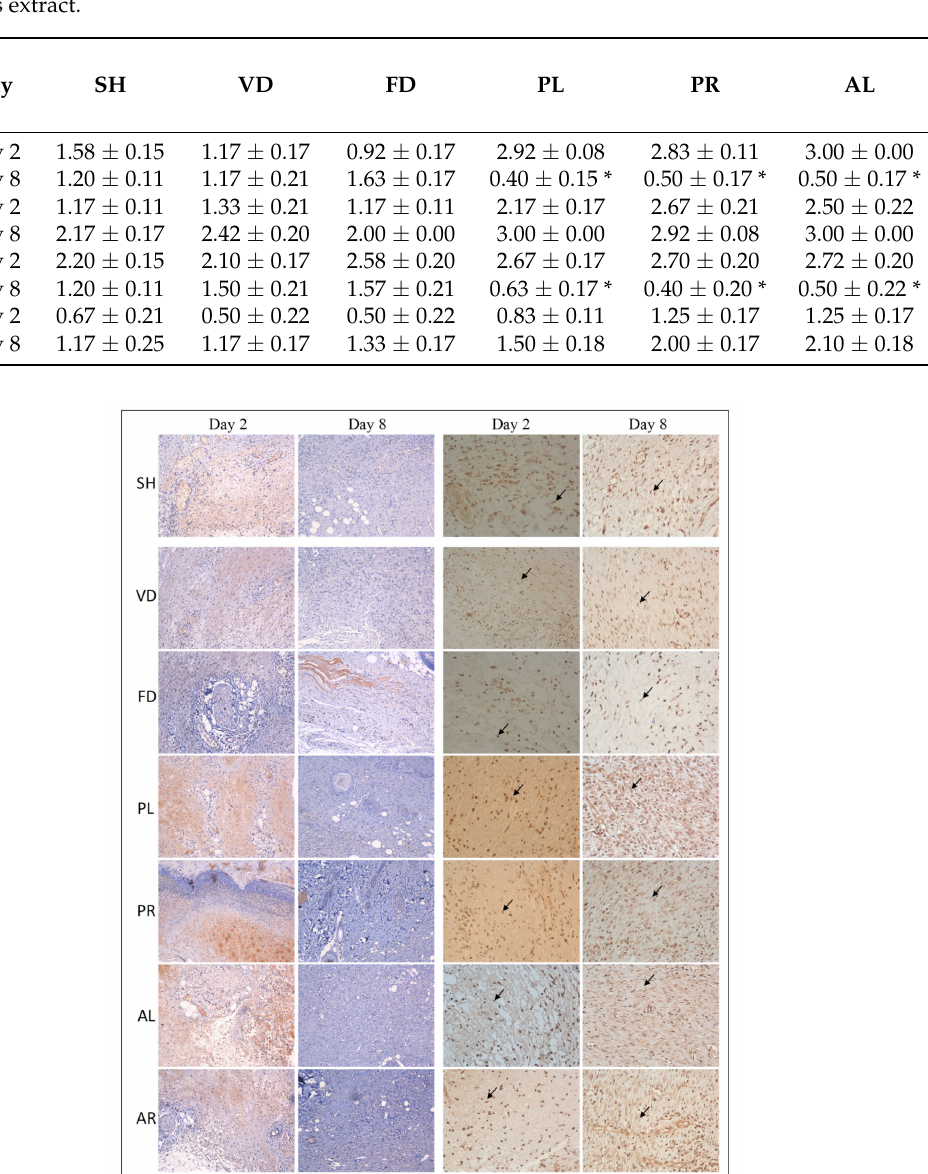
Table 5. Mean score of proteins expression obtained by immunohistochemistry (IHC) staining of seven male rat experimental groups: SH, VD, FD, PL, PR, AL, and AR. All data are given as mean ± S.E. for six animals in each group. Statistically significant results are indicated as (*) p < 0.05 versus untreated and control groups (SH, VD, and FD) on the same day. SH: sham control group (without treatment); VD: treated with vehicle (Cetomacrogol ointment); FD: treated with flavine (Acriflavine 0.1%); PL: treated with 1.0% concentration of MPvp leaves extract; PR: treated with 1.0% concentration of MPvp stem roots extract; AL: treated with 2.0% concentration of MPva leaves extract; AR: treated with 2.0% concentration of MPva stem roots extract.